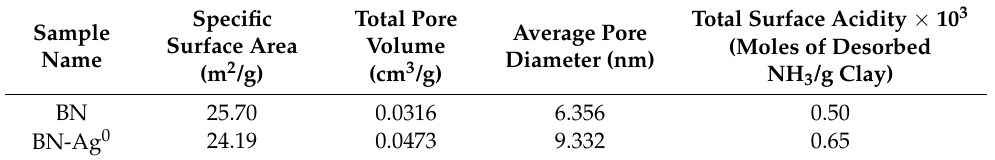
Table 2. Textural results of BN and BN-Ag 0 .